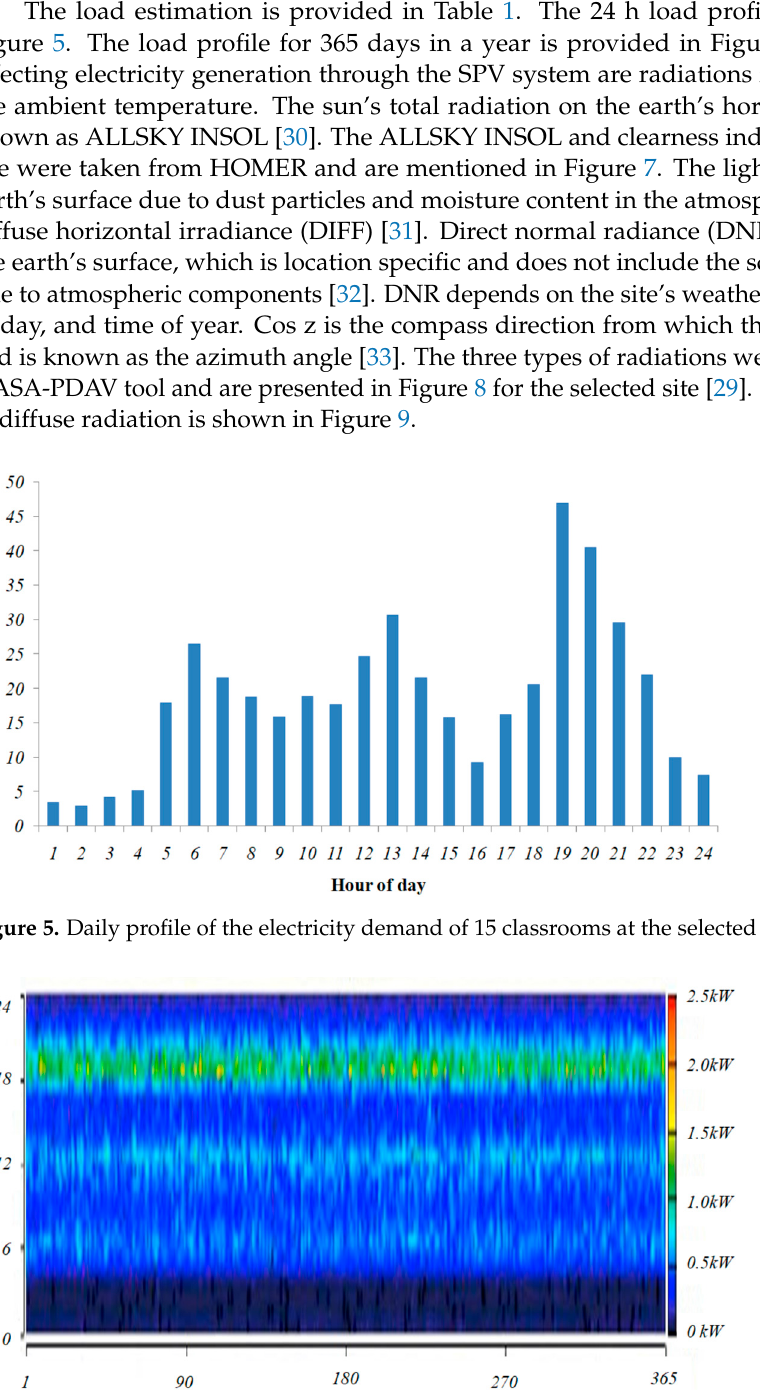
Figure 4. Proposed configuration of HPGP.